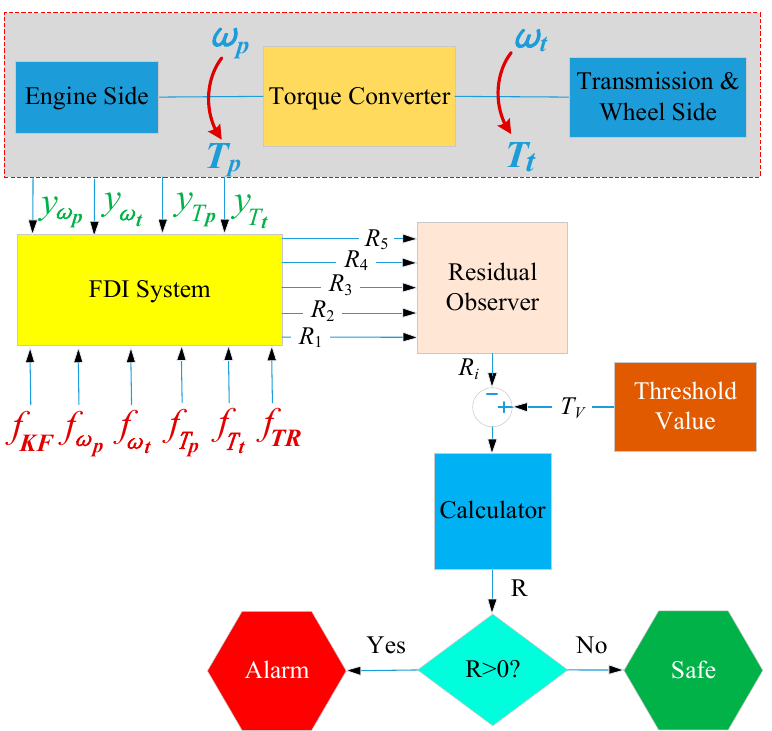
Figure 8. Diagram of the fault detection and identification (FDI) system.